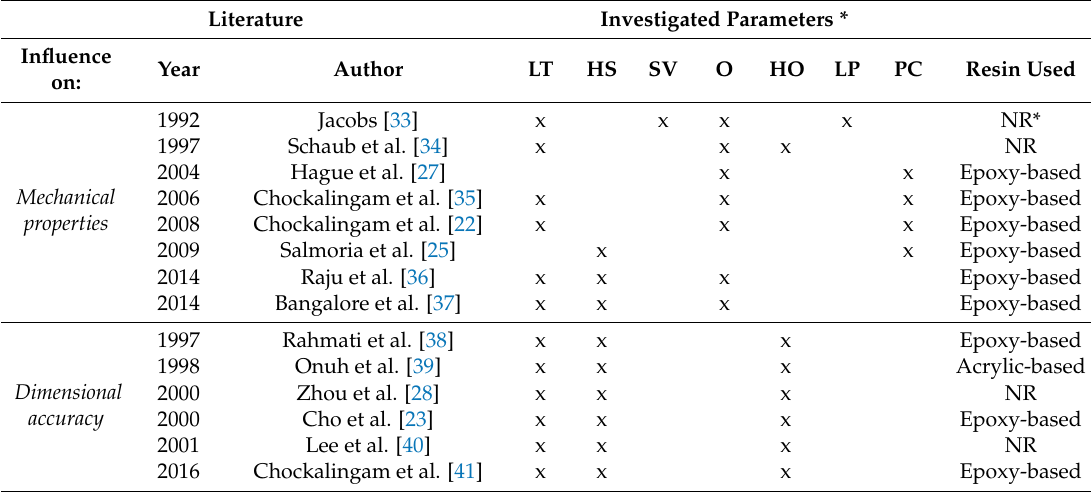
Table A1. Literature review on influence of printing parameters on mechanical properties and dimensional